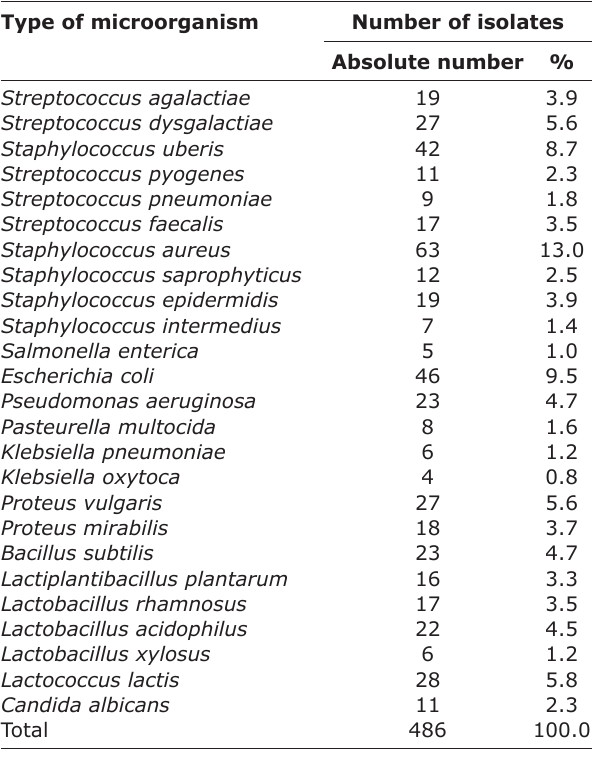
Table-2: Species analysis of the microbiota of milk cows with mastitis (n=103). Type of microorganism